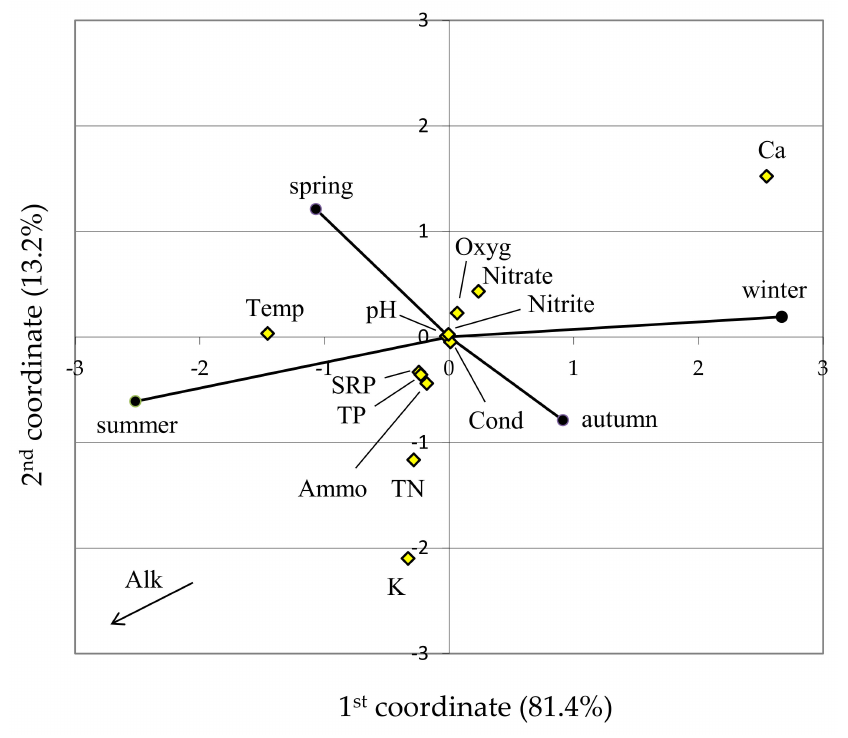
Figure 9. Position of measuring series determined by physicochemical parameters in the space of the first two canonical varieties and spacing of these parameters in the dual space (trait coordinates rescaled and multiplied by 0.4).